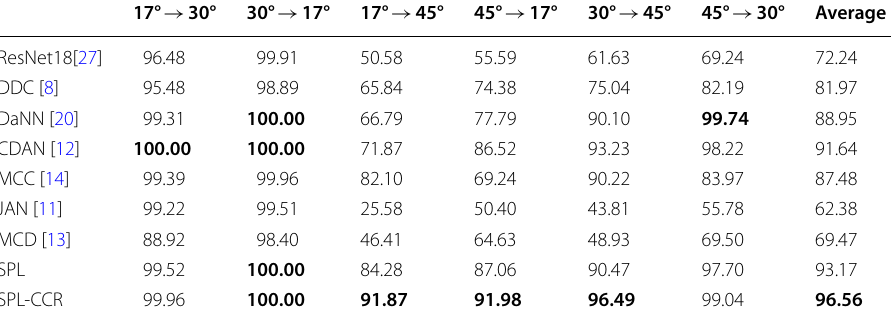
Table 3 Classification results of different methods on MSTAR